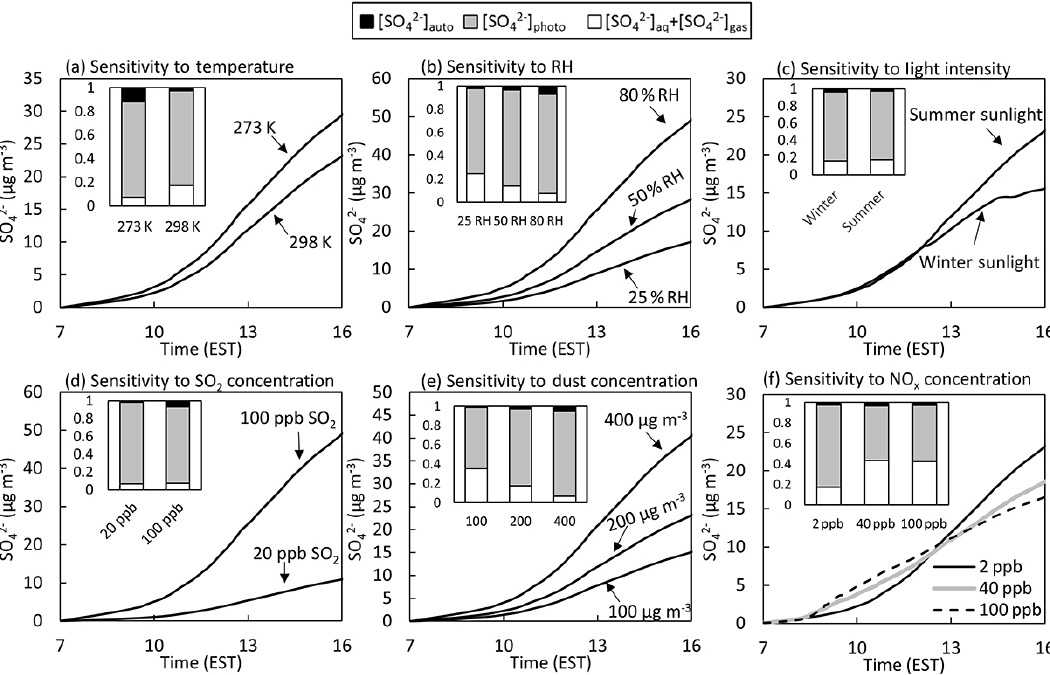
Figure 5. Sensitivity test of AMAR model to (a) temperature at 273 and 298K; (b) RH at 25, 50, and 80%; (c) sunlight profiles of sum- mertime (25 April 2017) and wintertime (12 November 2015) at Gainesville, Florida (latitude/longitude: 29.64185 ◦ / − 82.347883 ◦ ); (d) the concentration of SO 2 ; (e) the concentration of dust particles; and (f) the NO x concentration (initial NO:NO 2 = 1 : 1). The stacked column chart in each figure illustrates how total sulfate is attributed to major pathways at the end of each experiment. For the sensitivity test, the chamber simulation is conducted with 100ppb of initial SO 2 , 2ppb of initial NO 2 , 2ppb of initial O 3 , and 200µgm − 3 of ATD particles at T = 298K and RH = 40% under ambient sunlight on 25 April 2017. NO x (rate of flux = 2.7 × 10 6 , s − 1 ) and isoprene (rate of flux = 2.7 × 10 6 , s − 1 ) were constantly added to simulate chamber dilution. The simulation was performed without considering the particle loss to the chamber